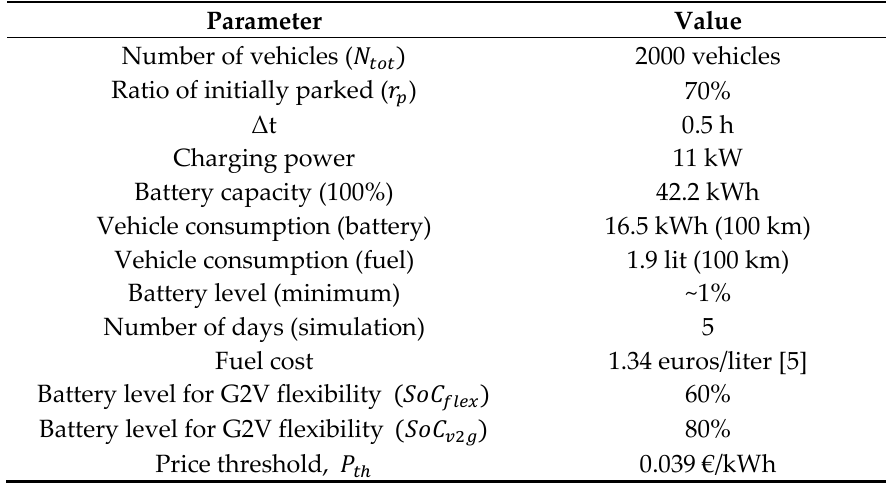
Table 1. Simulation parameters.